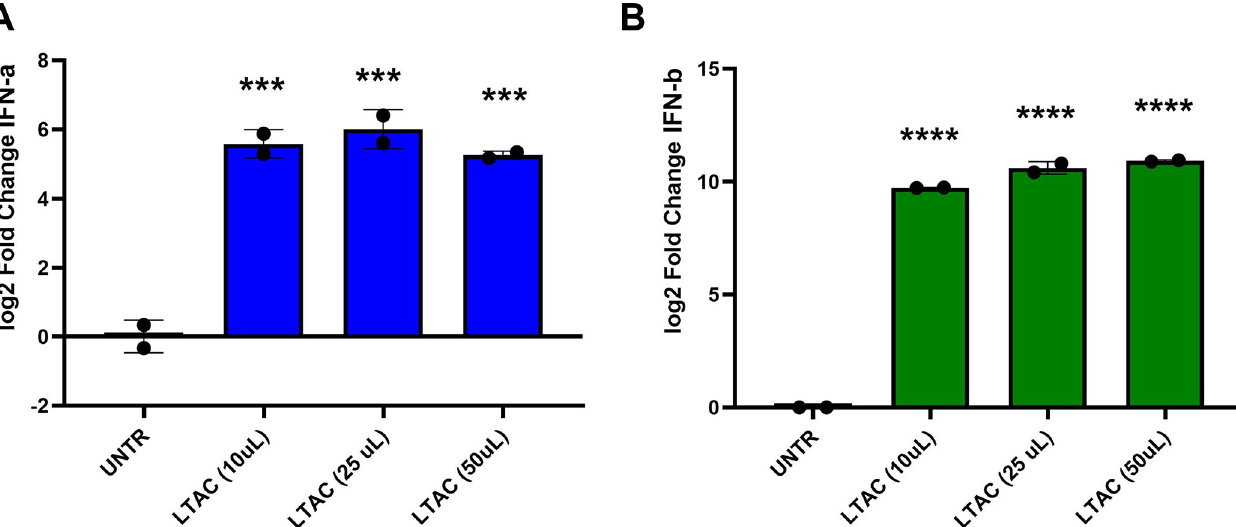
Fig 2. Activation of type I interferon responses by in vitro treatment with LTAC nanoparticles. Feline Fcwf-4 macrophages were seeded in 24-well plates overnight, and then stimulated for 8 hours with 3 different concentrations of LTAC nanoparticles. Following treatment, RNA was extracted and transcript abundance for A ) interferon- α and B ) interferon- β determined by quantitative RT-PCR. Significant induction of both IFN- α and IFN- β transcripts was observed at all 3 LTAC concentrations evaluated. Statistical evaluation of study data was done using ANOVA, and Tukey-Kramer post-test, with significance set at p < 0.05. Similar results were obtained in one additional, independent